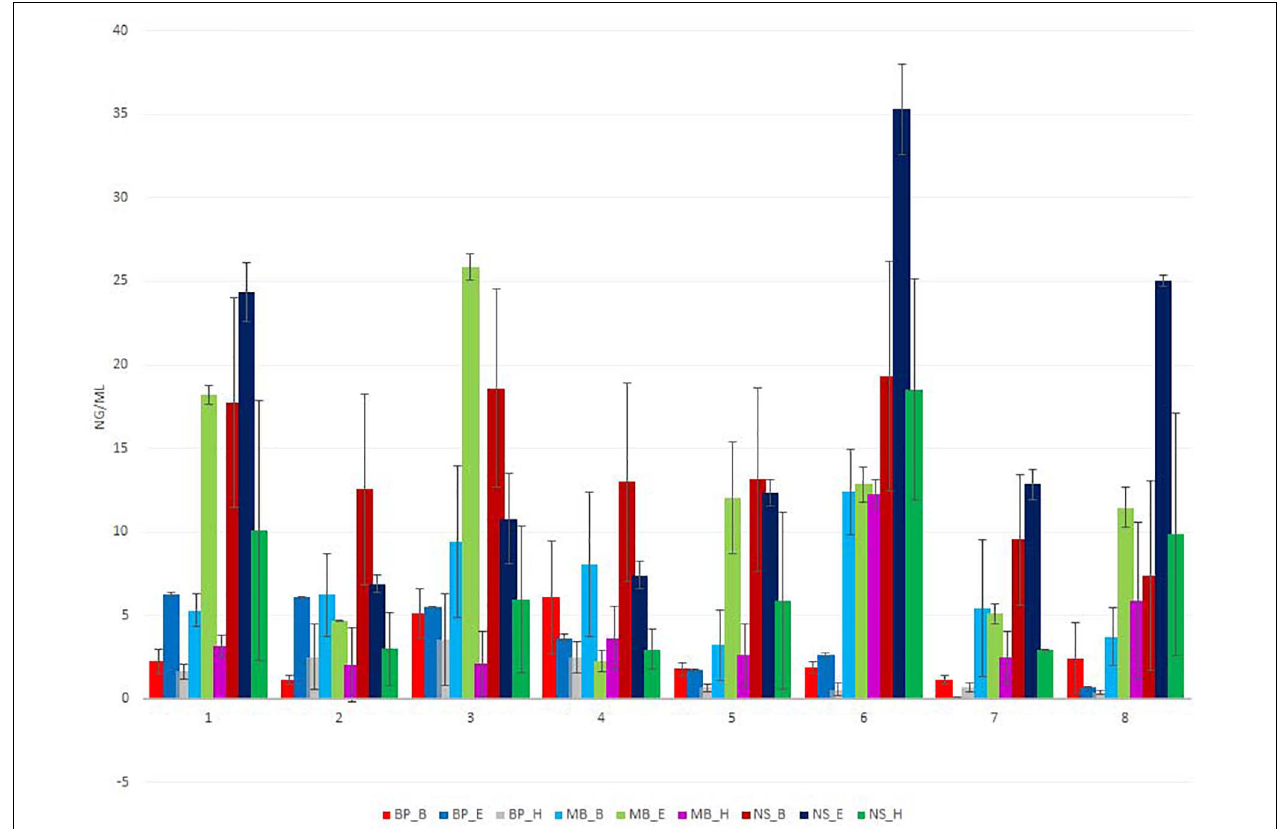
FIGURE 1 | Total extracted DNA yield (ng/ µ l) for eight different sausage samples isolated using nine different protocols, measured by Qubit. Each of the nine DNA extraction protocols is indicated by a unique color; abbreviations for the samples and the protocols are given in Tables 1 , 2 ,